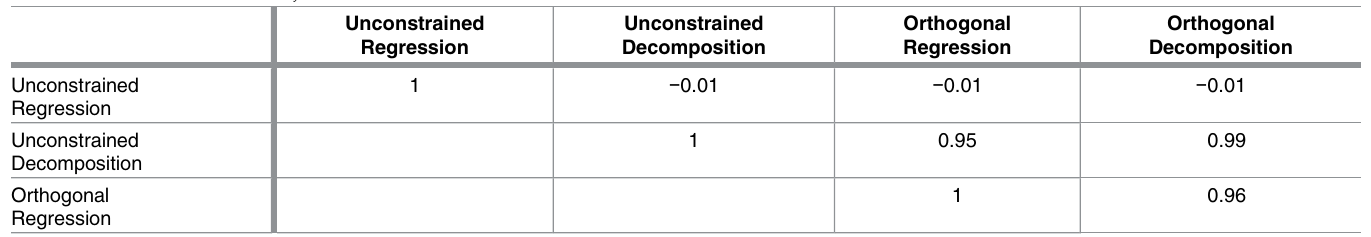
values for each j